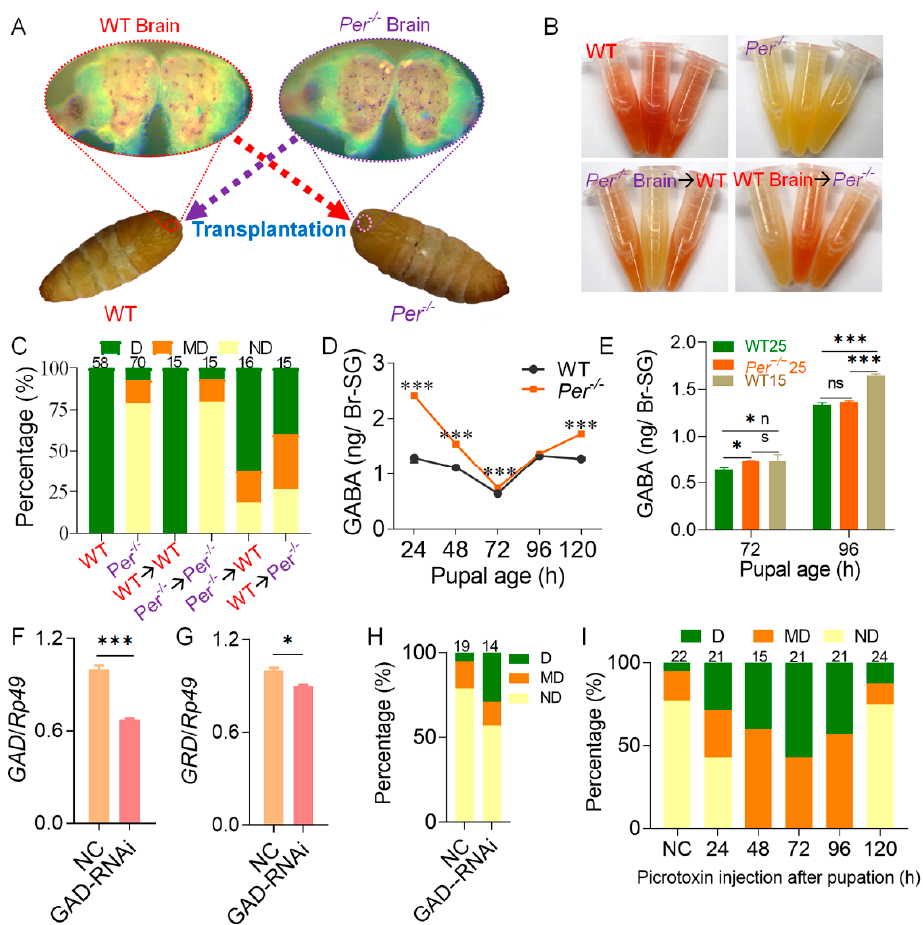
Figure 4. Deletion of Per affects diapause via the neurotransmitter GABA in the pupal brain. ( A ) Schematic of brain transplantation. Brain transplantation was performed on female pupae with ages of 10 h (±1 h). ( B ) Effect of brain transplantation on the content of 3-hydroxykynurenine. The 3-hydroxykynurenine content of intact ovaries from moth ages of 3–6 h was detected using Ehrlich’s diazo reaction. ( C ) Effect of brain transplantation on egg diapause. Absorbance of Ehrlich’s diazo reaction was used to judge the diapause types according to the diapause classification criteria ( n = 15–70 female moths). ( D , E ) The content of GABA in Br-SG of pupae. The parental embryonic incu- bation was 25LD ( D ), 25LD and 15LD ( E ). ( F , G ) Efficiency of interference with GAD on the diapause of Per − / − . GAD-RNAi, GAD interference dsRNA was injected at pupal age of 48 h. NC, invalid inter- ference fragments were injected. The mRNA levels of GAD ( F ) and GRD ( G ) in Br-SG were meas- ured 24 h after injection ( n = 3). ( H ) Effect of GAD-RNAi on diapause. The ND batches rate was 79% in NC and the ND rate declined to 57% after GAD-RNAi ( n = 14–19 batches). ( I ) Picrotoxin treatment can rescue the diapause of Per − / − . 90 µg picrotoxin was injected into each Per − / − pupa. The control (NC) was injected with 30 µL sterile water at pupal age of 24 h. The diapause was determined by the content of 3-hydroxykynurenine in the moth ovaries ages of 3–6 h ( n = 15–24 female moths). In figure ( D – G ), * p < 0.05; *** p < 0.001, n = 3. In figures ( F – I ), eggs were incubated in 25LD. Further treatment of the Per knockout pupae with the GABA receptor blocker, picro- toxin, showed that reducing the effect of GABA rescued the diapause process of the Per − / − silkworms. After injection with picrotoxin during pupal age 24–120 h, according to the diapause classification criteria of Ehrlich’s diazo reaction, the evaluation results showed